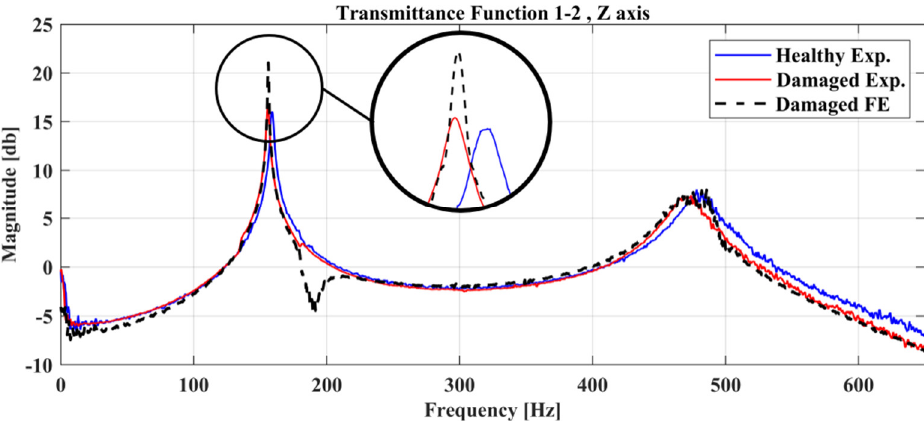
Figure 23. Comparison of the Transmittance Functions 1-2 between the damaged and healthy ex- perimental measurements along with the damaged FE Model.